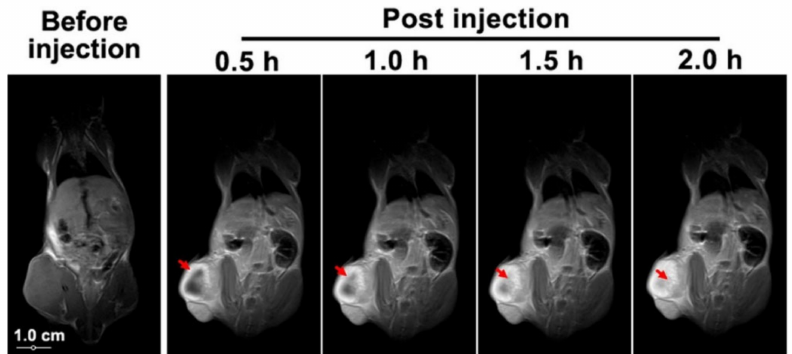
Figure 9. Magnetic resonance of A549 tumour-bearing mice prior and post injection of poly-graphene quantum dots-hyaluronic acid (PGQD-HA). Adapted with permission from Ref. [92]. Copyright 2019 American Chemical